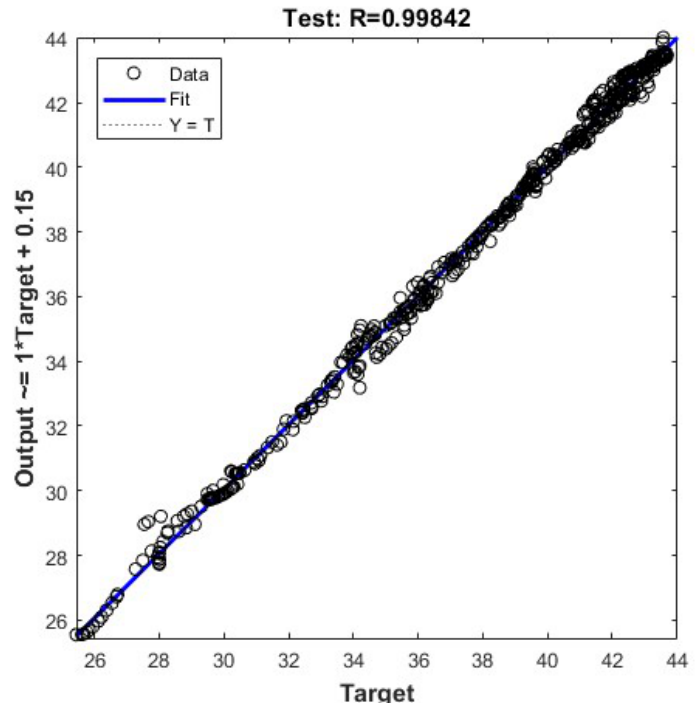
Figure 4. The results of linear regression for the temperature values in deposit measured using Celsius scale and determined using the MLP 4-7-1 model in relation to the testing file (of data).